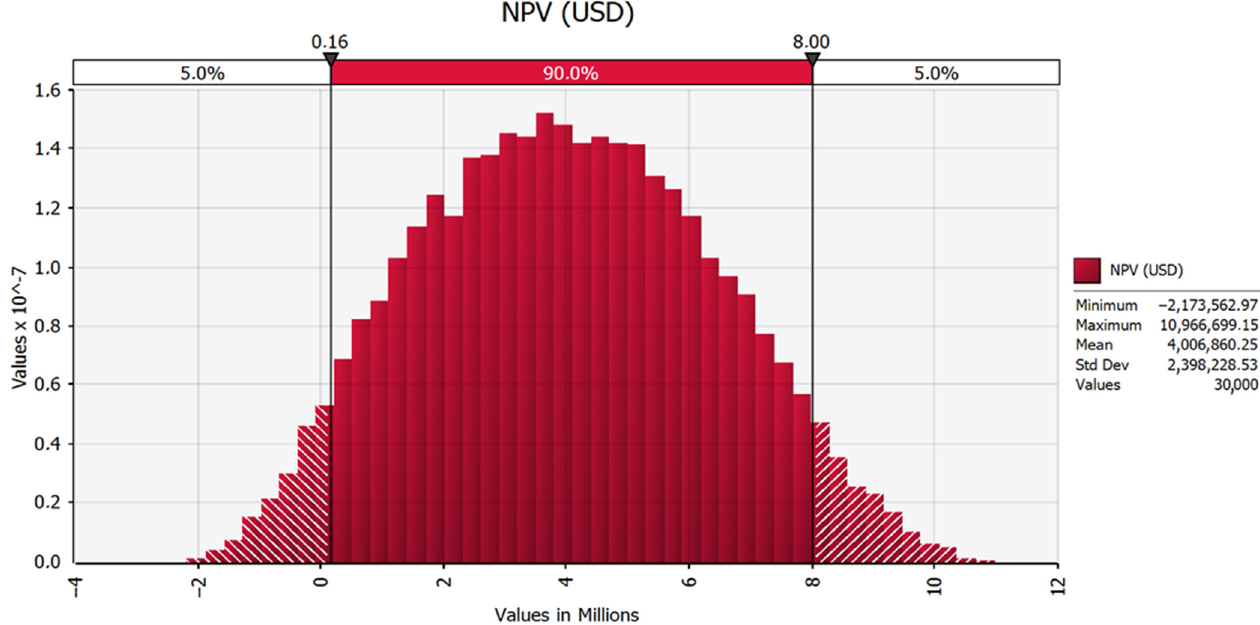
Figure 7. Sensitivity analysis on SL production from WOC by SSF on the net present value (NPV) for the WS scenario under the conditions assumed in the model. Nomenclature: WS: wheat straw; WOC: Winterization oil cake.